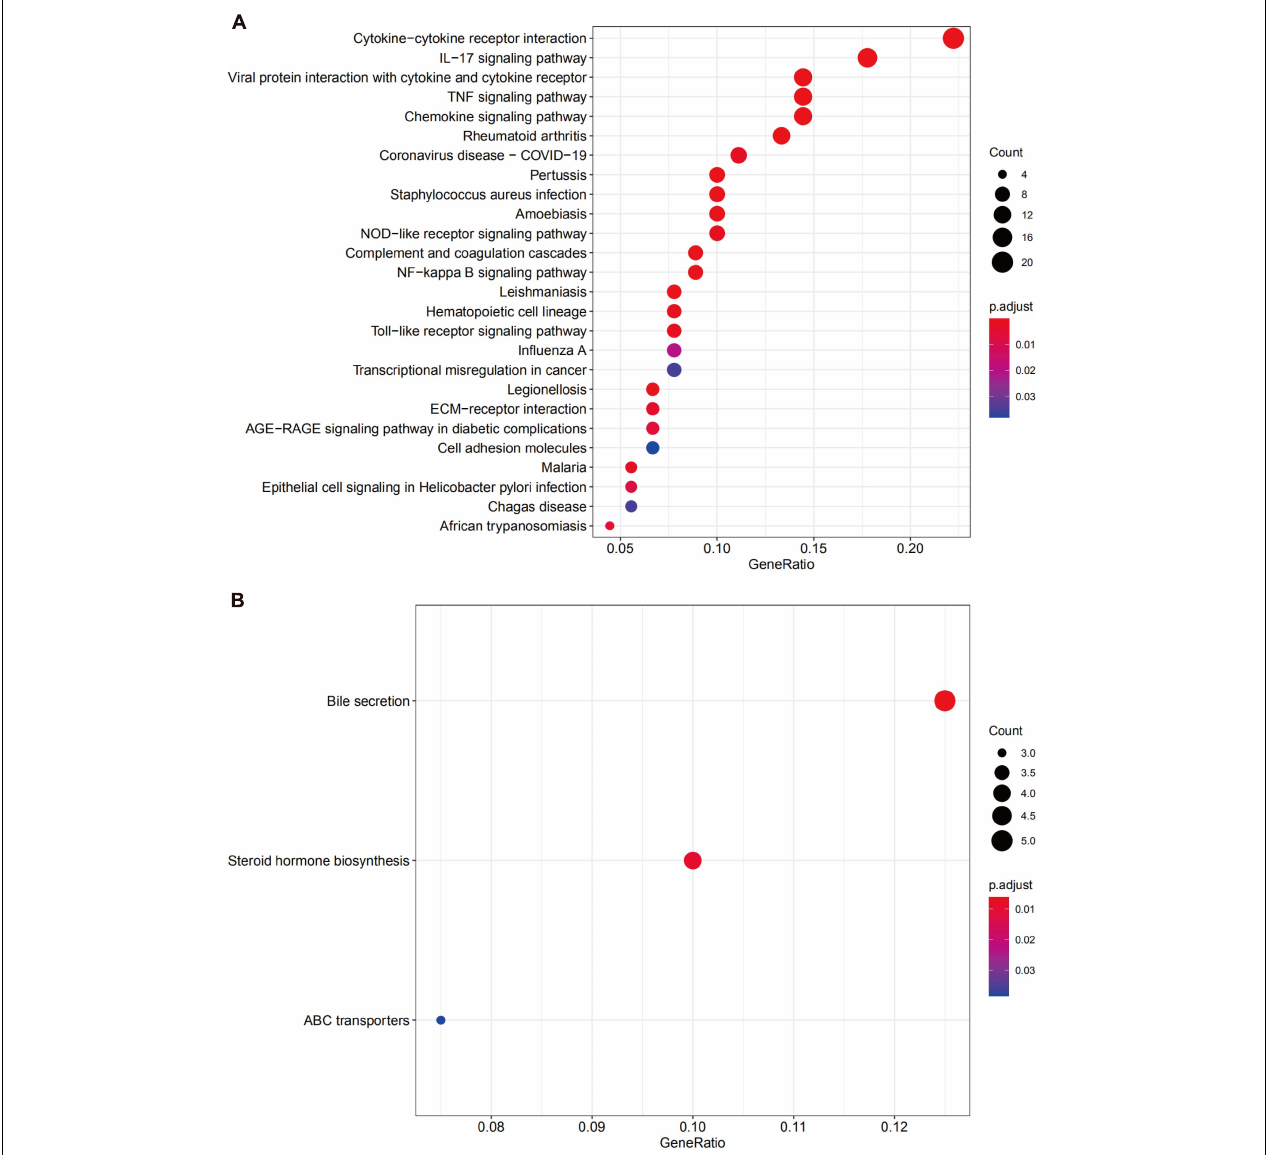
FIGURE 5 | The Kyoto Encyclopedia of Gene and Genome (KEGG) pathway enrichment analysis for DEGs. (A) The functional enrichment analysis of upregulated genes. (B) Functional enrichment analysis of downregulated